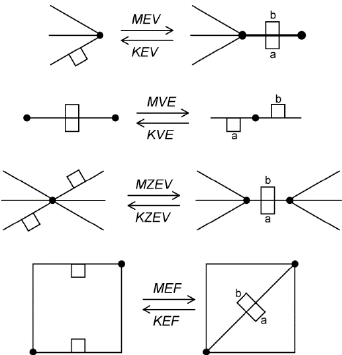
Figure 12. Euler operators: MEV/KEV, MVE/KVE, MZEV/KZEV, MEF/KEF (a, b—new half-edges).